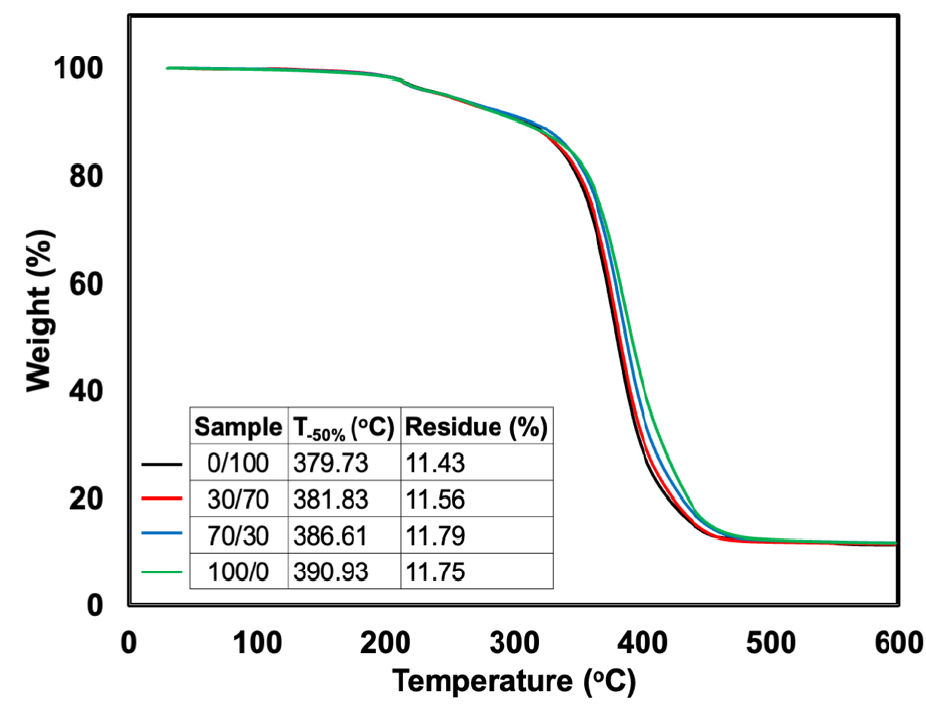
Figure 12. TG curves of SR/NR blends.